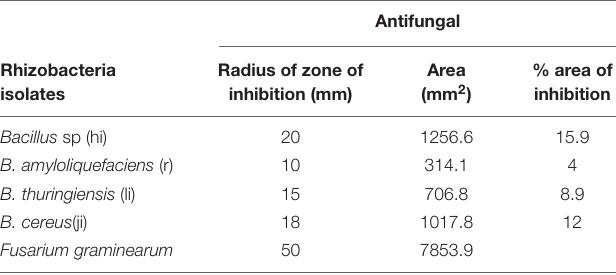
Voda and Chvalina farms during spring and autumn, ranging between 4 and 14 ppm N, although some of the values from this study are higher (Vanˇek et al., 2003). These higher values